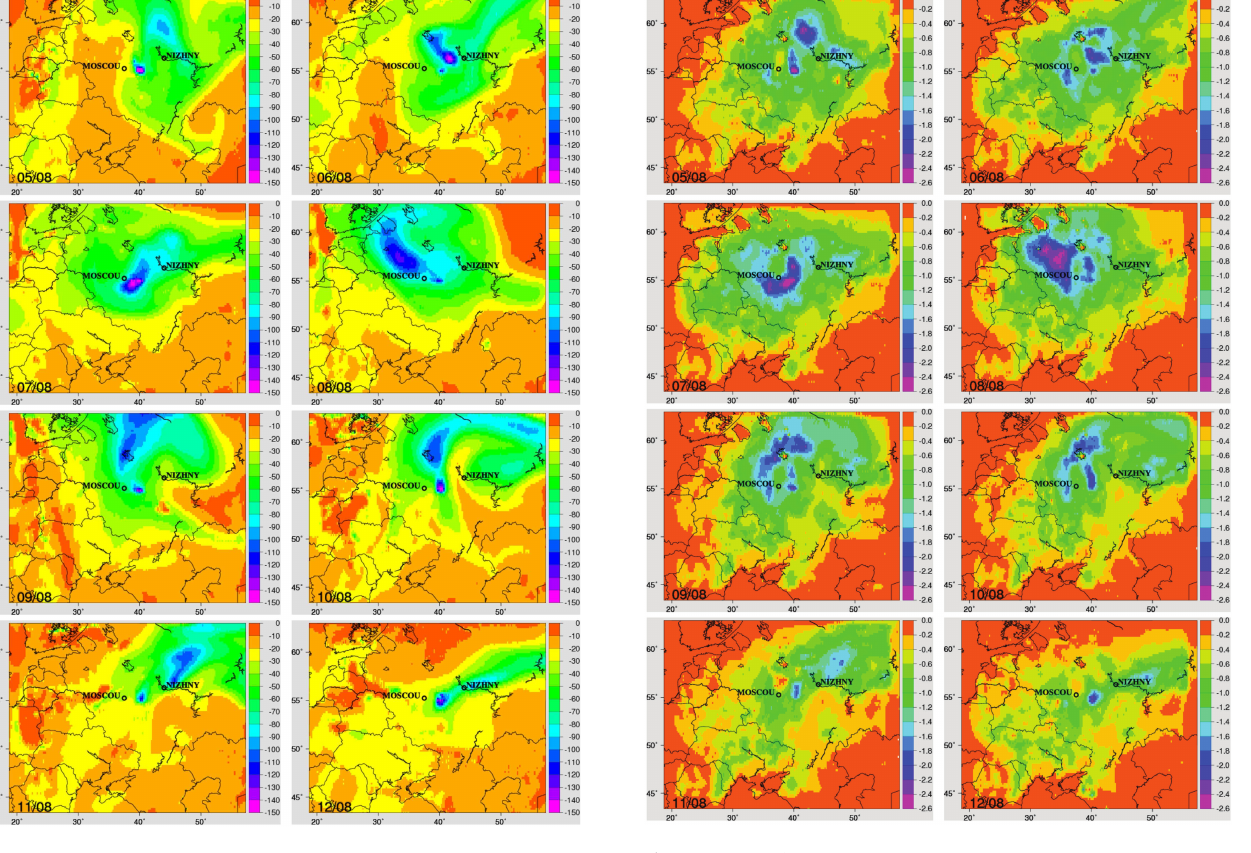
Fig. 7. Geographic distribution of the diurnal-averaged shortwave ADRF (in Wm − 2 ) simulated at the surface for between 5 and 12 August 2010.